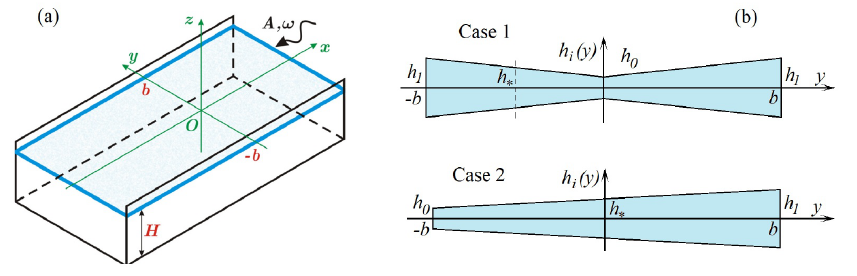
Figure 1. Scheme of the channel ( a ). Schemes of the profile of the ice across the channel ( b